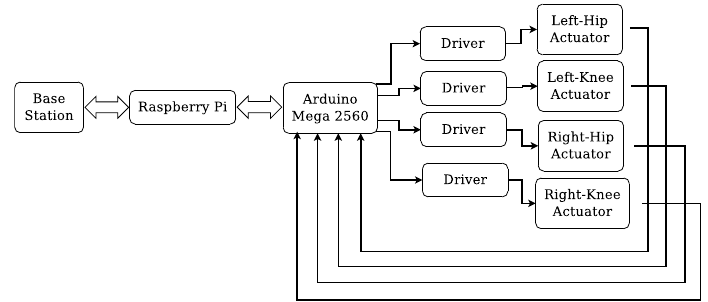
Figure 2. Hardware structure of